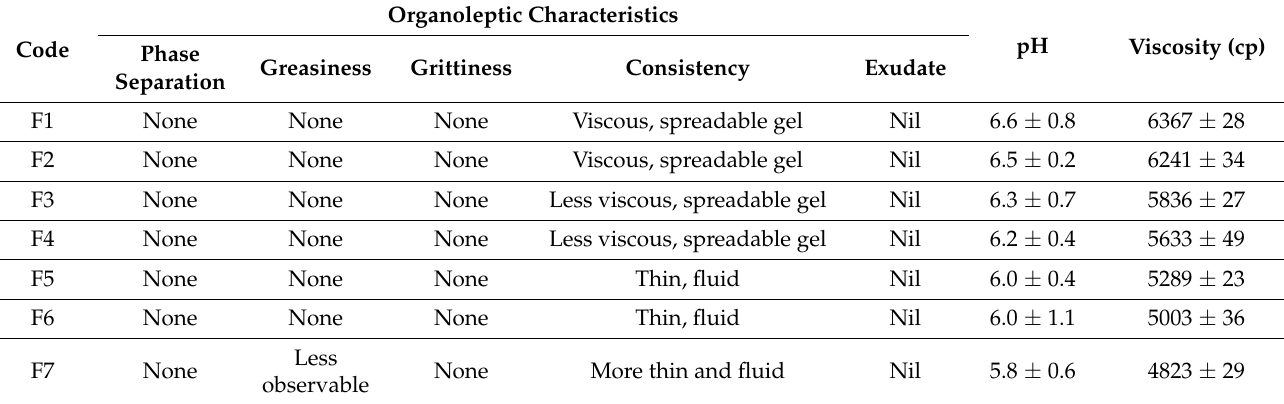
Table 2. Organoleptic characteristics, pH and viscosity (means ± SD, n = 3) of different formulations.